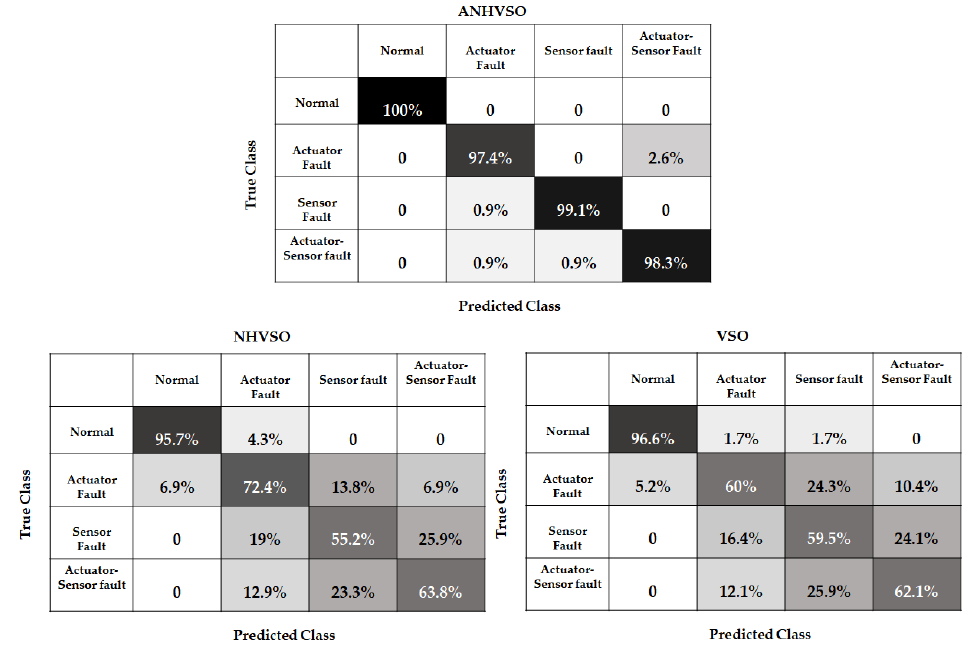
Figure 7. Confusion matrices for the ANHVSO, NHVSO and VSO algorithms based on the SVM technique. Table 3. Fault diagnosis results for the robot manipulator based on ANHVSO, NHVSO and VSO.